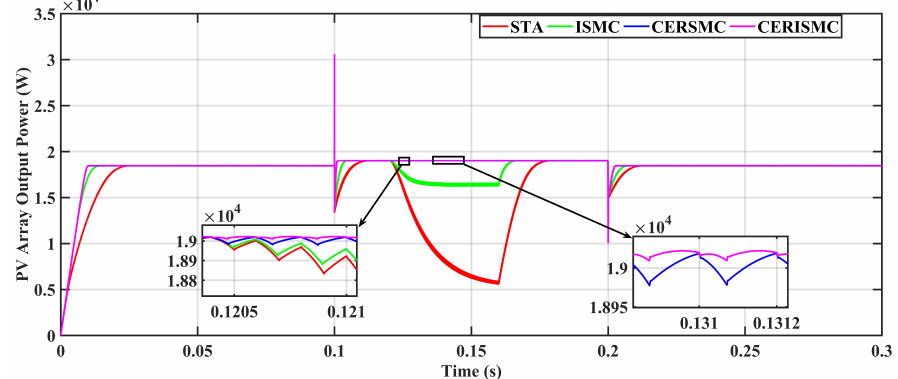
Figure 10. PV array output powers under varying irradiance, temperature, load and a charging station.